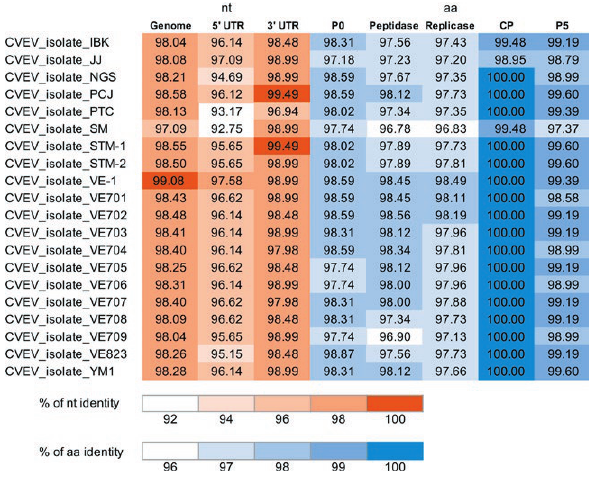
Figure 2. Percentage of nucleotide (nt) and amino acid (aa) sequence identity between the CVEV Italian isolate 14Q and full- length CVEV isolates in databases. Scales of colour identify similar nt and aa identity scores. The accession numbers of the virus iso- lates are reported in Figure